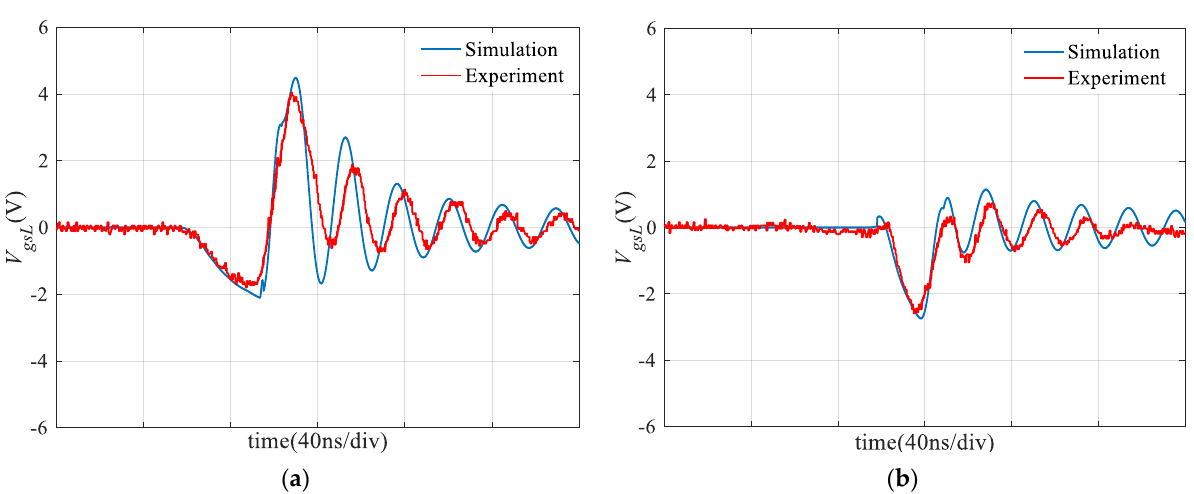
Figure 19. Double plus test waveforms.